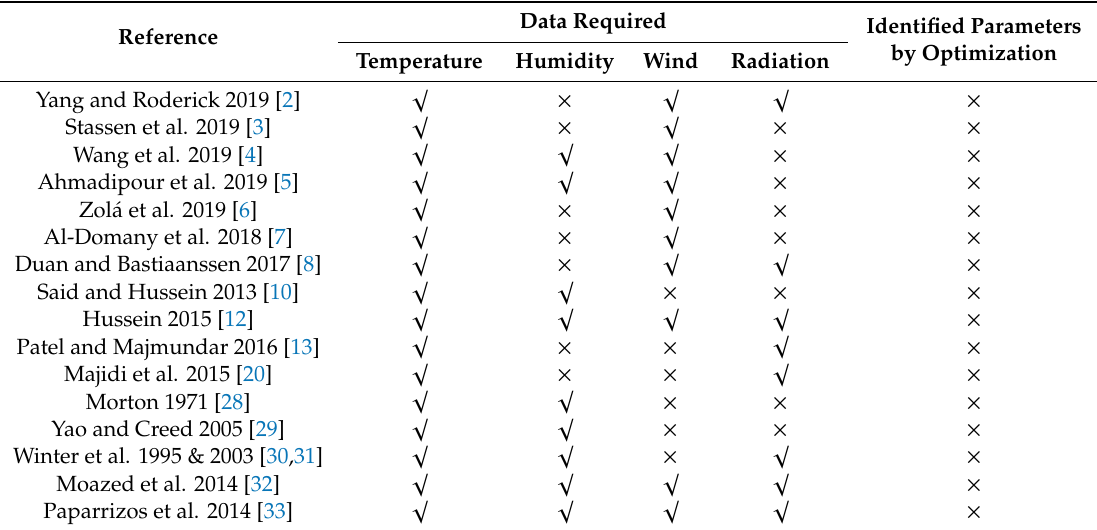
Table 1. Data requirements and review of publications regarding evaporation